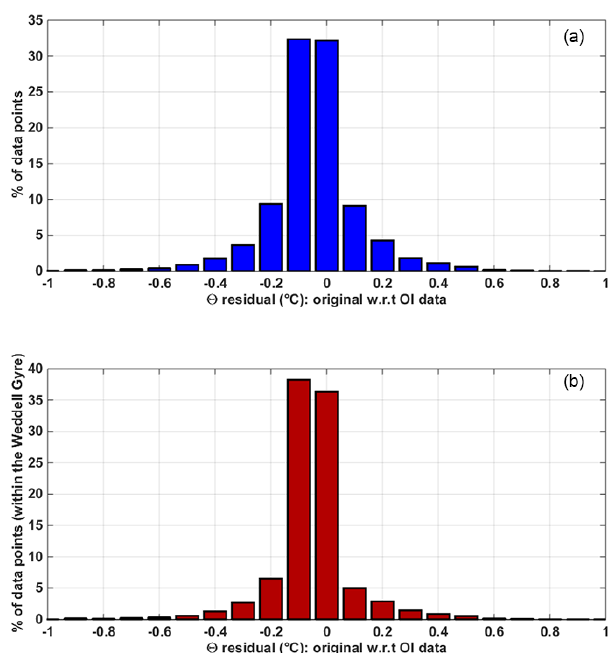
Figure 17. A histogram showing the percentage of data points binned by temperature residuals ( ◦ C) at 800dbar, where the float data objectively mapped to the profile locations (i.e. Fig. 16b) are subtracted from the original profile data points (i.e. Fig. 16a), for (a) the entire data set and (b) for those data points within the “de- fined” Weddell Gyre region only.